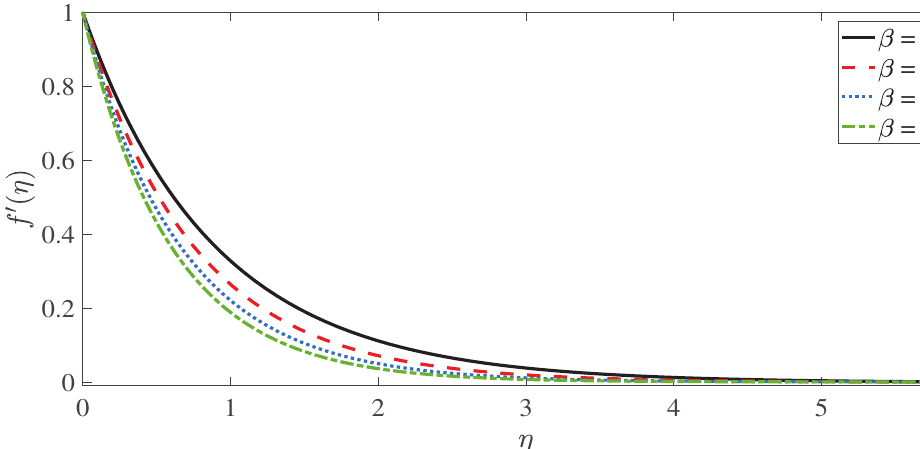
Figure 3. Velocity profile for magnetic parameter β .